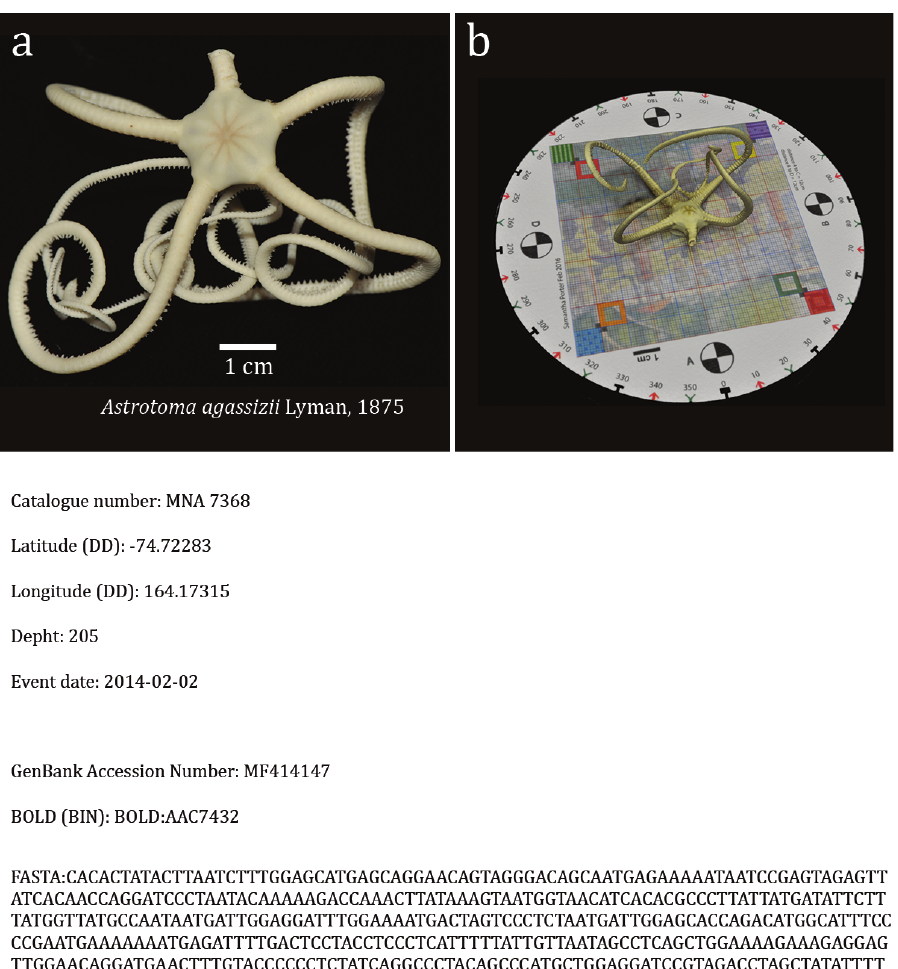
Figure 9. a The A. agassizii (MNA 7368) specimen used for photogrammetry documented immediately after collecting b screenshot of the 3D model based on photogrammetry at the mesh reconstruction stage (the marker showed as model background is available as supplementary material in Porter et al. 2016); Catalogue number, latitude (DD), longitude (DD), depth and event date as described in the section “Dataset description”; GenBank Accession number, the Barcode Index Number from the Bold system and the complete COI sequence in FASTA